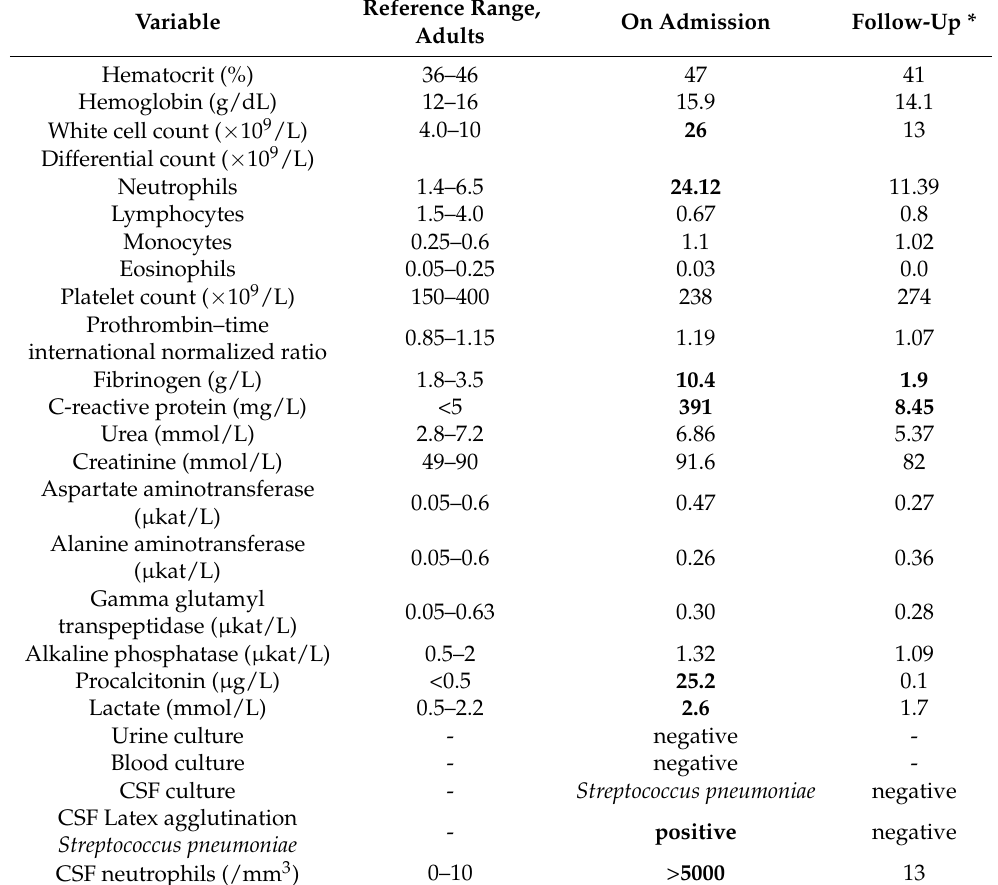
Table 1. Laboratory